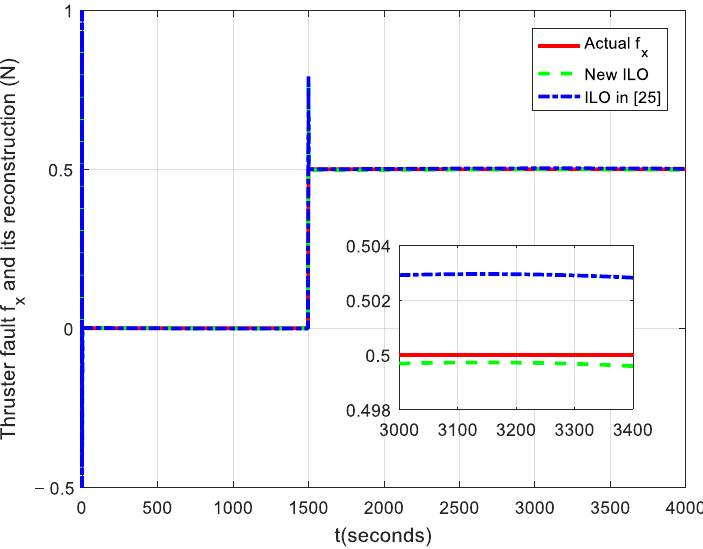
Figure 6. The fault-reconstructing results obtained using the newly designed ILO and the existing ILO.